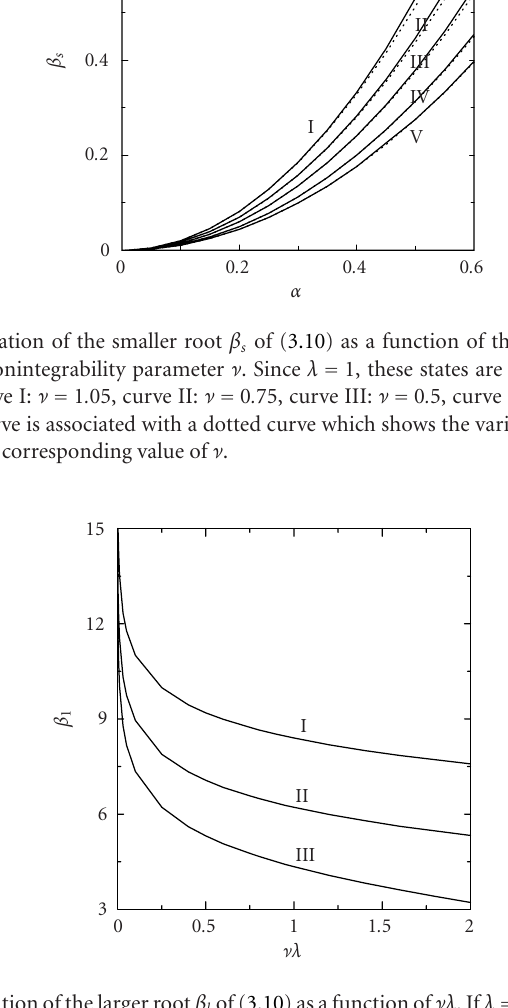
Figure 3.3. The variation of the larger root β l of (3.10) as a function of ν λ . If λ = 1, these states are then unstaggered stationary localized states. Curve I : α = 0 . 1, curve II: α = 0 . 25, and curve III: α = 0 .